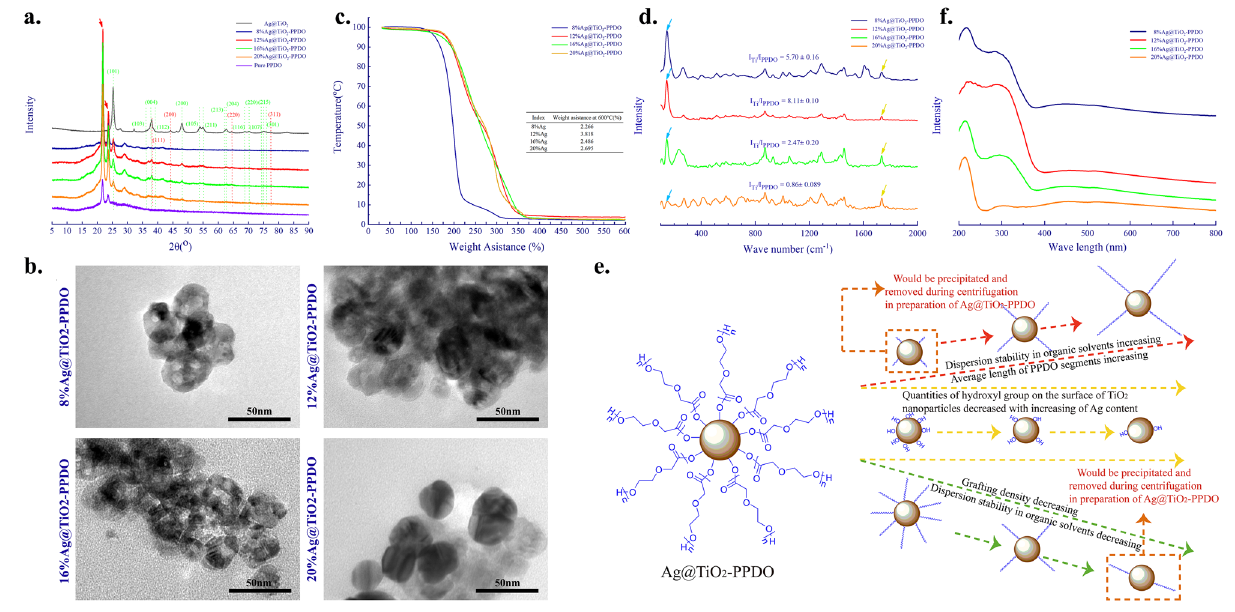
Figure 2. ( a ) XRD spectra of Ag@TiO 2 -PPDOs (red arrows indicates peaks of PPDO crystal, the green dotted line indicates peaks of TiO 2 crystal, the red dotted line indicates peaks of Ag); ( b ) TEM of Ag@TiO 2 -PPDOs; ( c ) TG curves of Ag@TiO 2 -PPDOs; ( d ) Raman spectrum of Ag@TiO 2 -PPDOs; ( e ) Affection of Ag content in Ag@